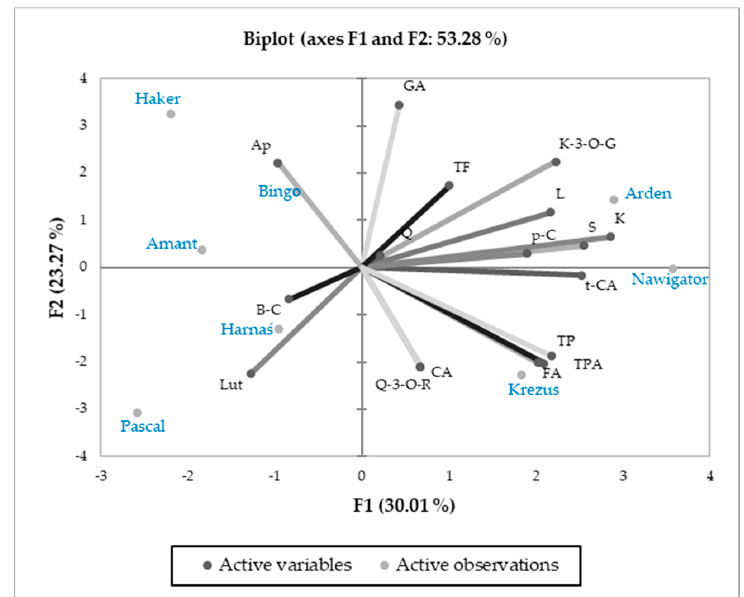
Figure 2. PCA biplot showing the relationships between the chemical composition of grains of the studied oat cultivars. Lutein (Lut), β -carotene (B-C), gallic acid (GA), ferulic acid (FA), caffeic acid (CA), t-cinnamic acid (t-CA), sinapic acid (S), p -coumaric acid (p-C), sum of phenolic acids (TPA), quercetin-3- O -glucoside (Q-3-O-R), kaempferol-3- O -glucoside (K-3-O-G), luteolin (L), quercetin (Q),